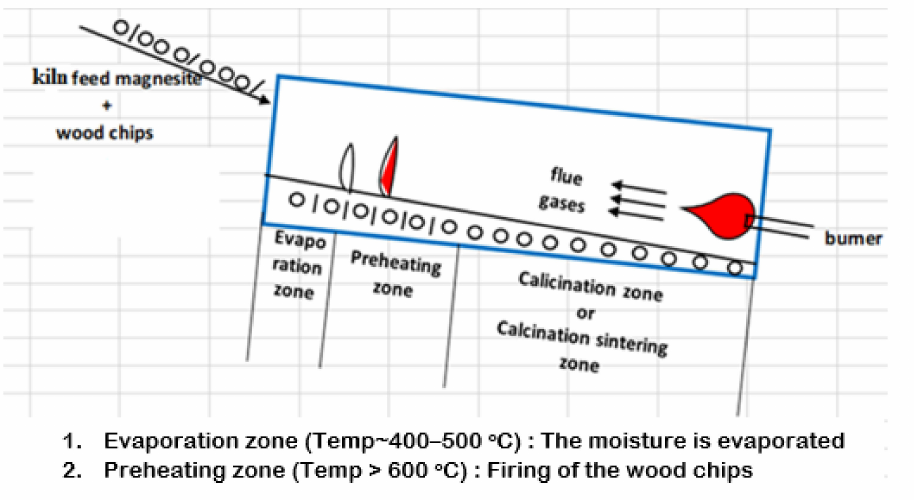
Figure 4. Biomass at GM: Co-feeding with raw